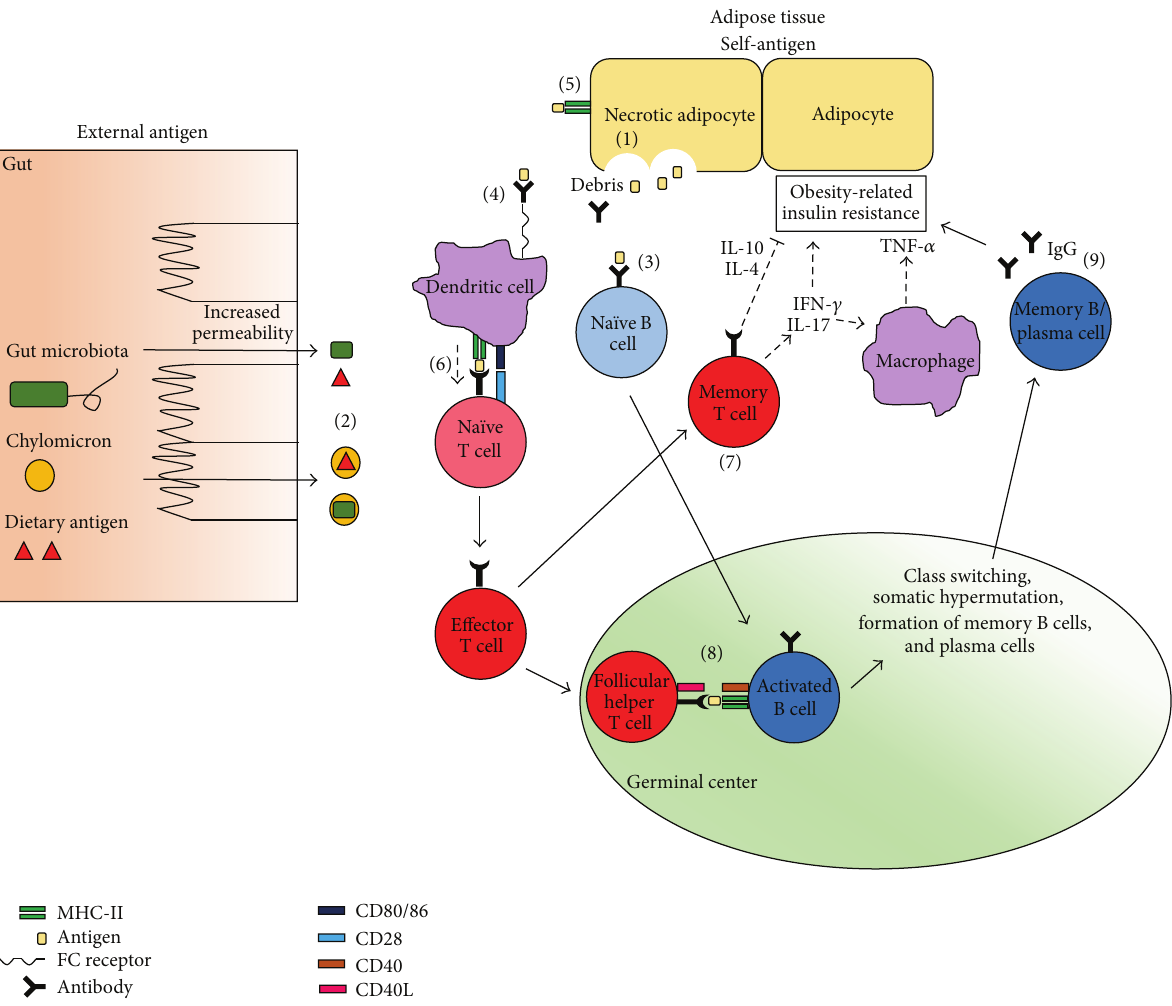
Figure 1: Possible antigen-specific processes in IR pathogenesis. The antigens targeted in IR can come either from self or external sources, so long as they are chronically available to the adaptive immune system. Necrotic death of adipocytes is one potential source of autoantigen (1). External sources of antigen include gut microbiota and dietary antigens, which may enter the circulation passively due to increased intestinal permeability or via chylomicron transport (2). When the antigen is present within the inflamed surroundings of the adipose tissue, B cells can recognize the antigen directly through their surface Ig receptors (3). Alternatively, soluble antibody can bind to the antigen and enable opsonization by macrophages or dendritic cells, which then process and present the antigen on MHC-II to cognate na¨ıve T cells (4). Adipocytes can also present antigen on MHC-II directly to T cells (5). If the T cell recognizes a correct peptide-MHC pair and receives CD28 stimulationandcytokinesignals,itdifferentiatesintoeffectorTcells(6).AfewofthesecellsformmemoryTcellswhichhavealowerthreshold for activation when they encounter the same antigen again (7). Activated T cells can also become follicular helper T cells which enter the germinal center to provide help to activated B cells that recognize antigens from the same antigen source (8). Activated B cells present antigen to follicular helper T cells and receive stimulation through their CD40 coreceptors (8), which licenses the cells to undergo antibody class switching, somatic hypermutation, and formation of memory B cells or long-lived plasma cells. Memory B cells also have a lower threshold for activation in a repeat encounter with antigen while the plasma cells maintain somatically hypermutated antibody production for the antigen (9). From these interactions, a strong, specific, and chronic immune response develops that leads to obesity-related IR. Not shown in this diagram are the regulatory cells that help to modulate these processes, for example, Tregs, Th2 cells, B-1a, and Breg